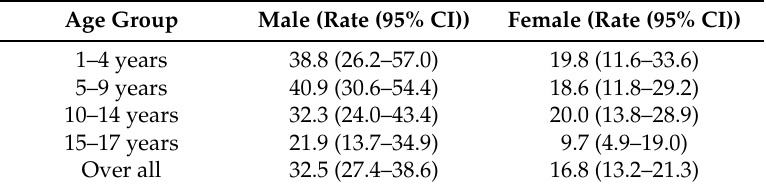
Table 2. Rates (per 1000) of non-fatal injuries by gender and age